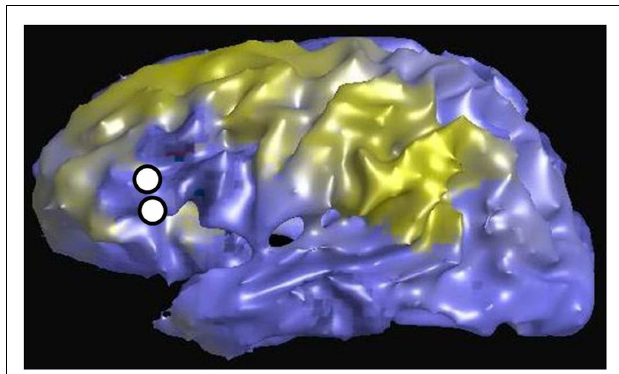
FIGURE 6 | Left lateral view of structural connectivity, using the electrode locations (white circles) stimulating Broca’s region as a seed and connecting to all other cortical gray matter voxels .This is the same patient shown in Figures 2 and 3 .The green color indicates higher structural connectivity, whereas blue color indicates lower structural